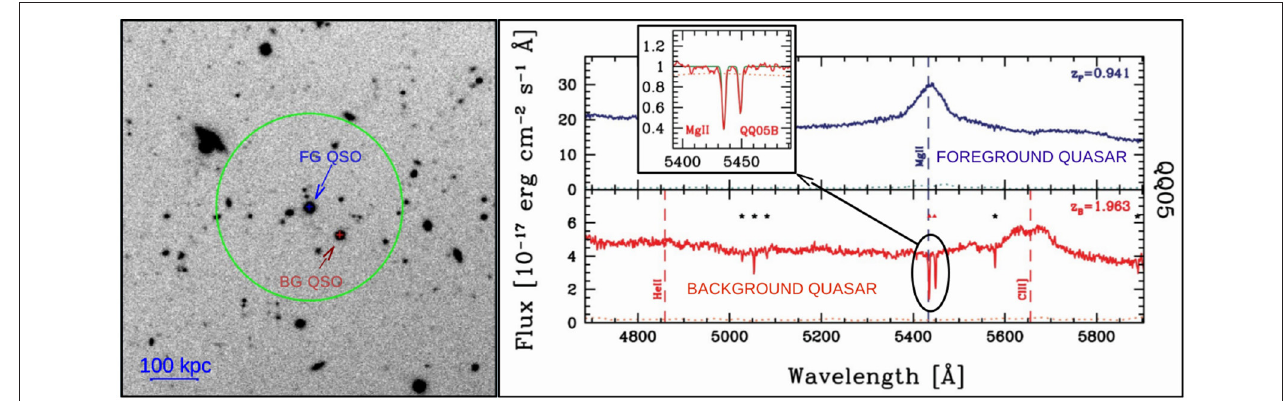
FIGURE 1 | Left : Image of projected quasar pair Q0059-2702. Blue and red arrows indicate the foreground quasar and the background one. Green circle shows the projected distance of 200 kpc from the foreground quasar. Right : VLT spectra of quasar pair Q0059-2702. The blue and red solid lines refer to foreground quasar and background quasar, respectively. The insert shows the zoom of Mg II absorptions at the same redshift of foreground quasar.